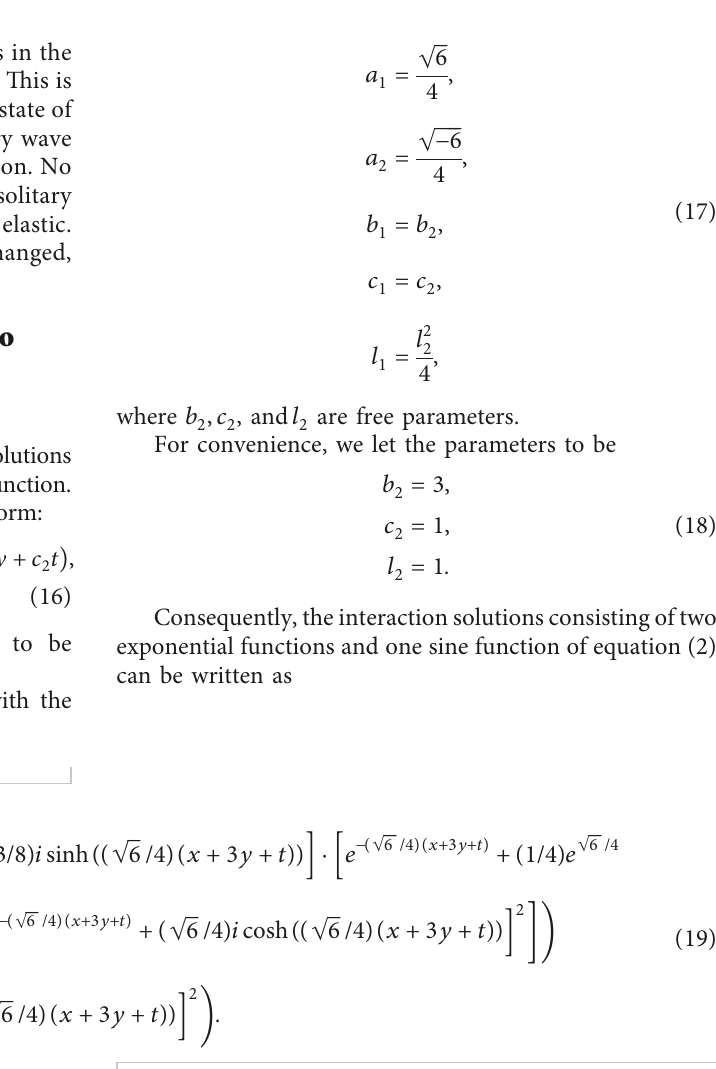
Figure 3: Fission phenomenon: plots of interaction solutions (15) with α (a) t � − 10; (b) t � − 3; (c) t � − 2; (d) t � 0; (e) t �